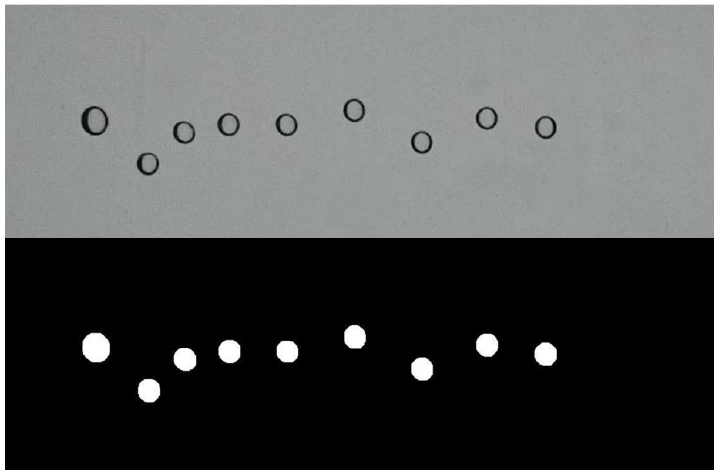
Figure 2. Example of image preprocessing for calculating the diameter and velocity of gas bubbles.